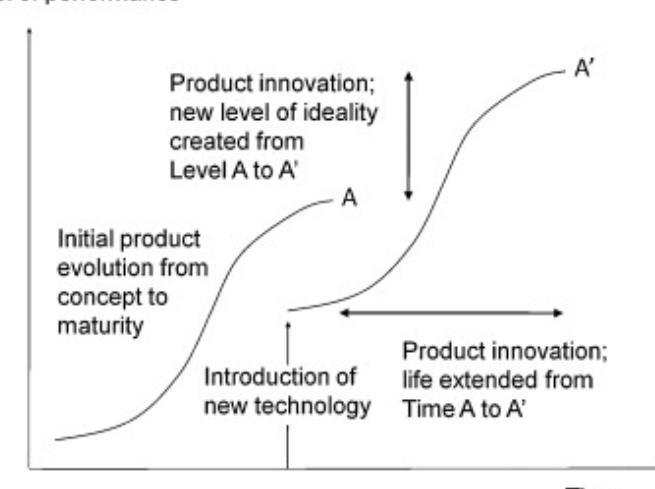
Figure 14. Evolutionary S-curve, showing technology shift effect [69].